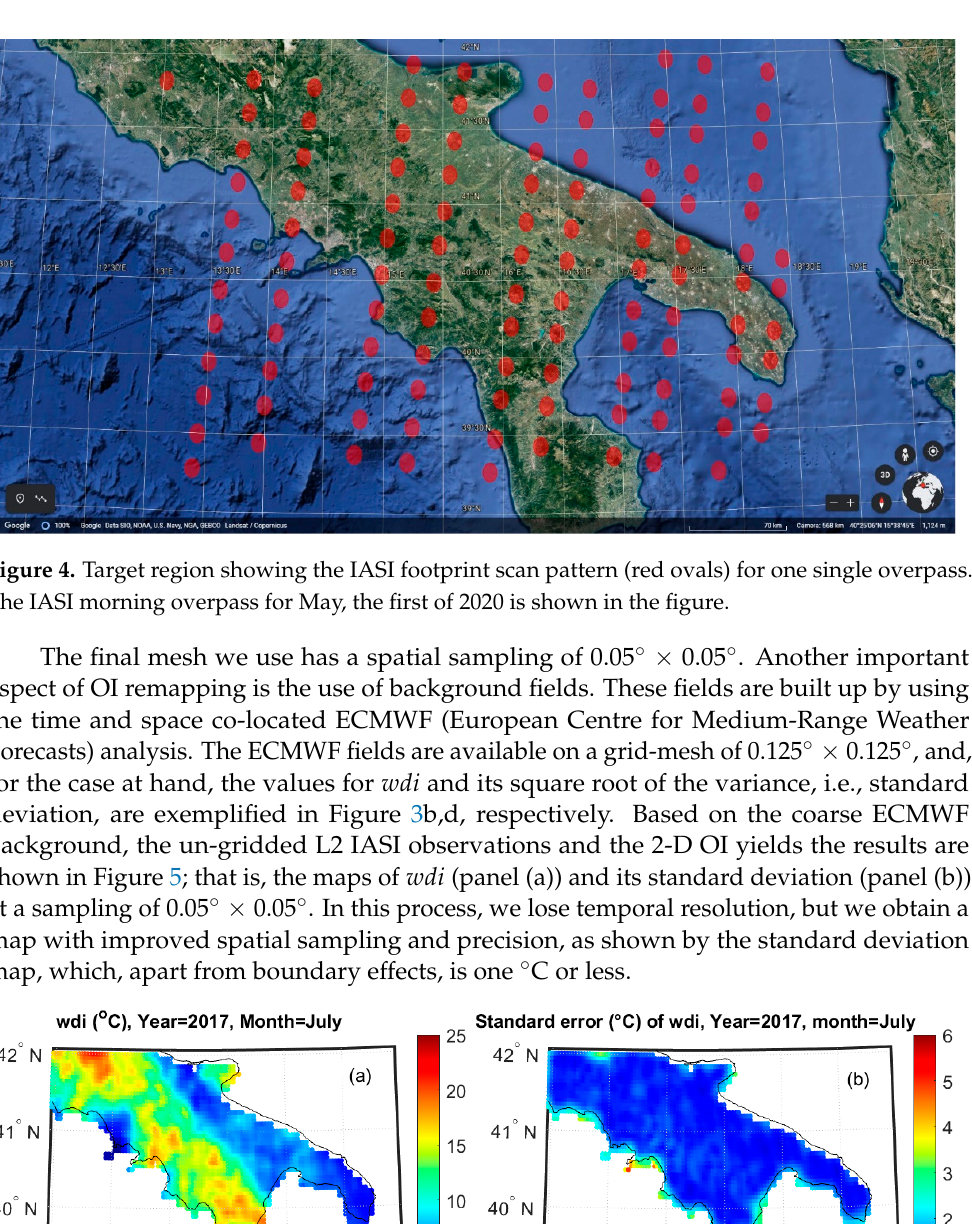
Figure 3. July 2017. IASI L2 products for 𝑤𝑑𝑖 (panel ( a )) and its standard deviation (panel ( c )) over the target area. The figure also shows the ECMWF background field (both mean (panel ( b ) and standard deviation ( d )) at its native spatial resolution of 0.125° × 0.125°.